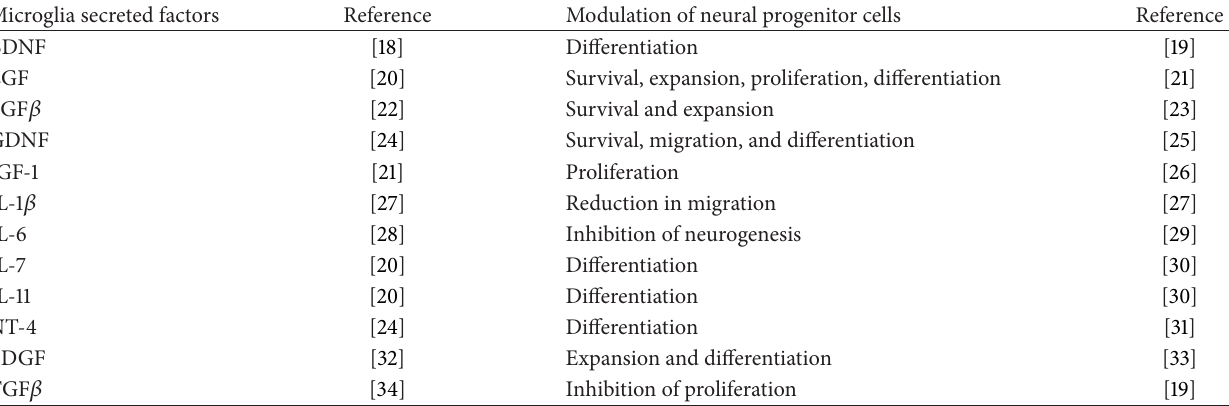
Table 1: Summary of factors secreted by microglia and the potential effect they have on neuroprogenitors in vitro .